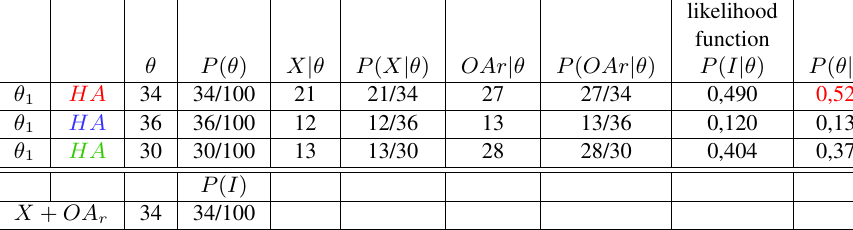
likelihood function